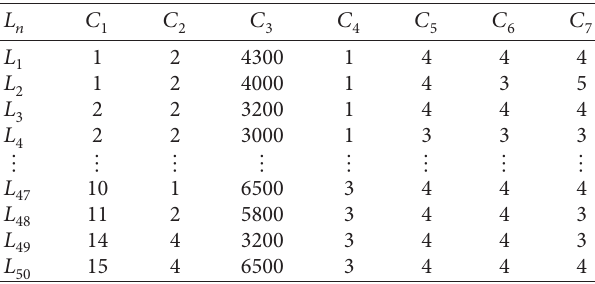
� [ a ] for landlords’ ij 2 2 50 × 50